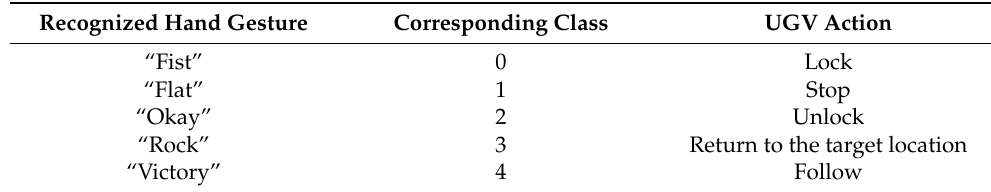
Table 1. Summary of the examined hand gestures along with the corresponding classes and actions to be executed by the